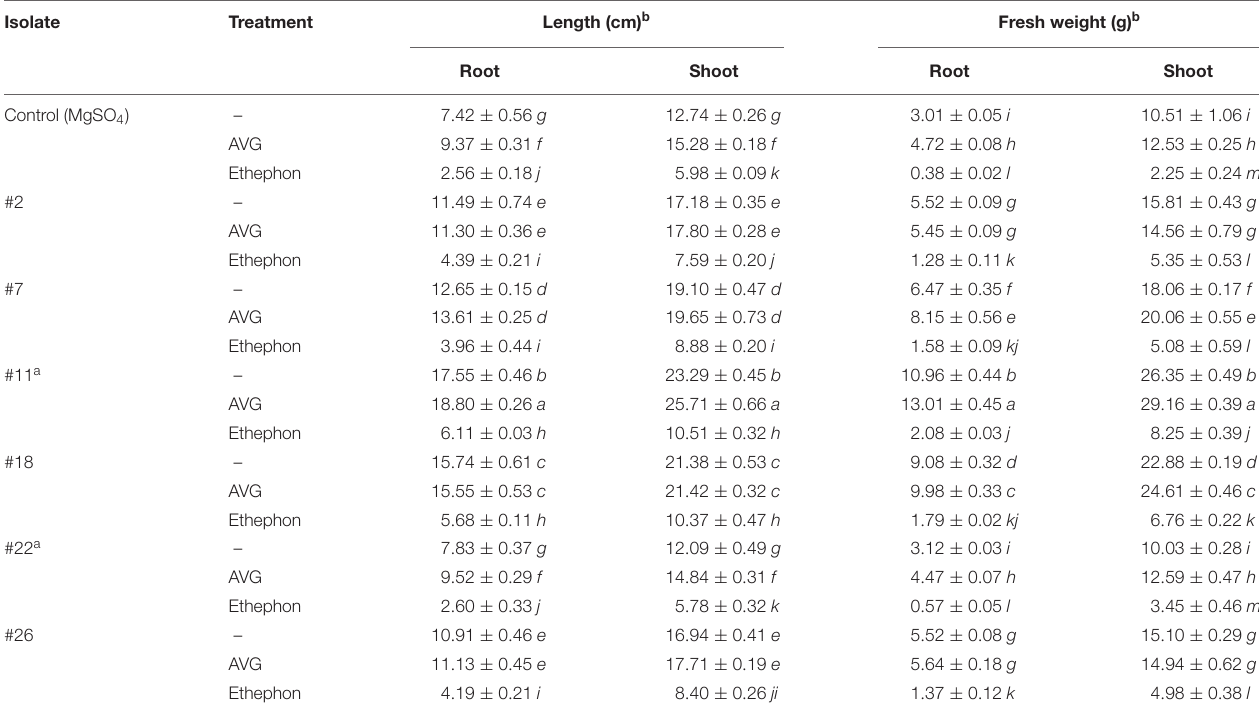
TABLE 2 | Comparisons on the effect of ACC deaminase-producing endophytic actinobacterial isolates on Salicornia bigelovii growth parameters in the presence of AVG (ET inhibitor) or ethephon (ET generator) under gnotobiotic conditions.